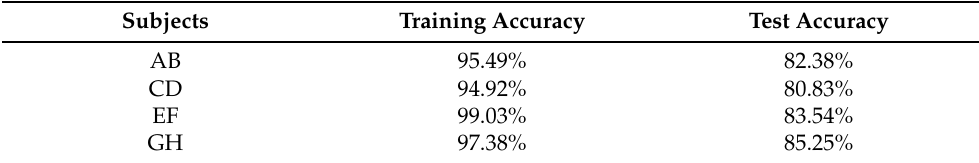
Table 5. Classification accuracy for each dataset subject.